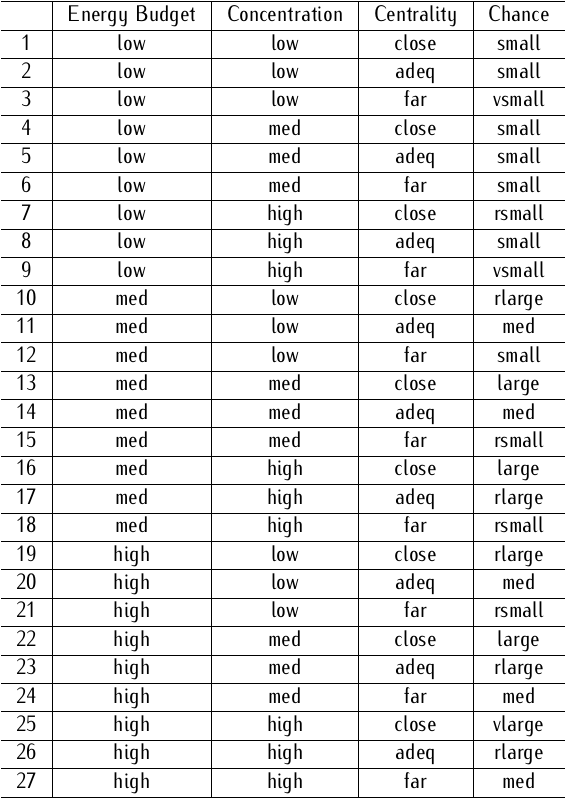
Table 1. Fuzzy rule